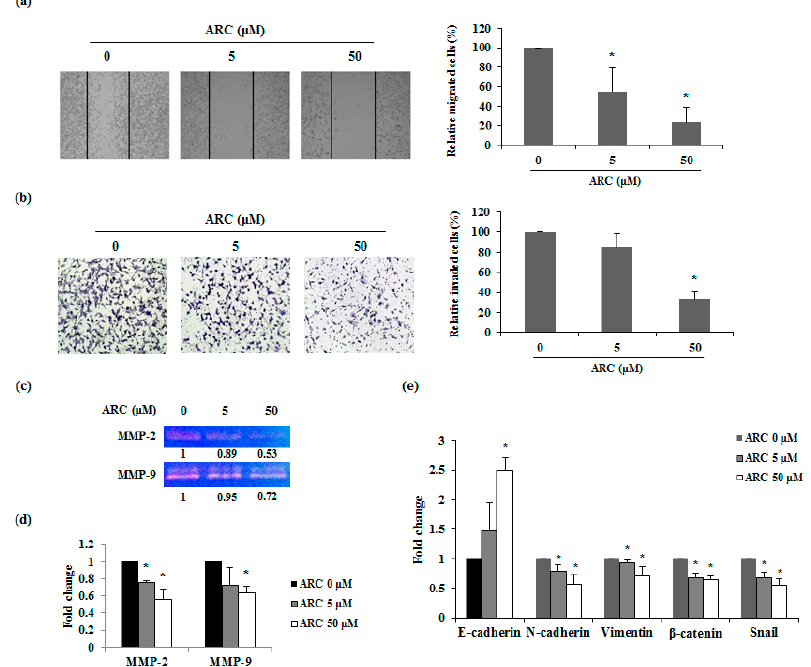
Figure 4. ARC reduces migration, invasion and mRNA expression of EMT transition markers. ( a ) Wound healing assay; and ( b ) invasion assay. Images were taken using a microscope (100× magnification); ( c ) Activities of MMP-2 and -9 in ARC-treated CT26 cells were determined by gelatin